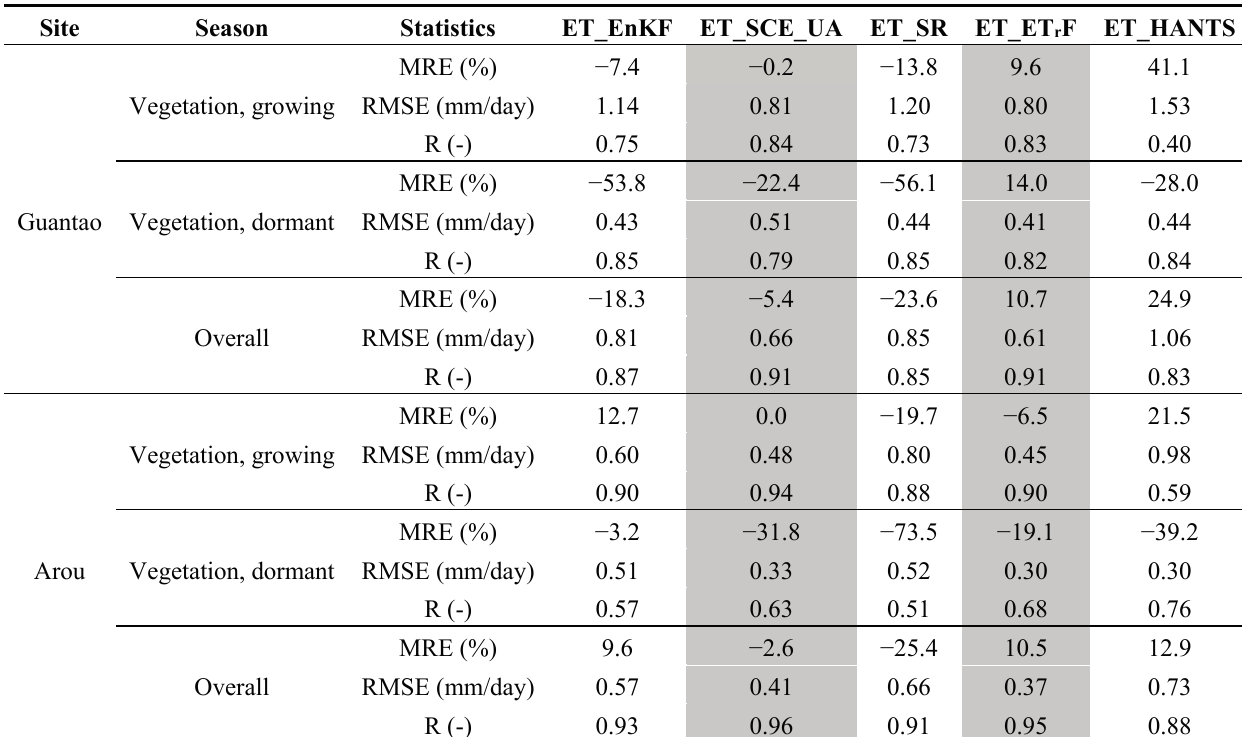
Table 5. The statistics of temporal reconstruction approaches at the Guantao and Arou